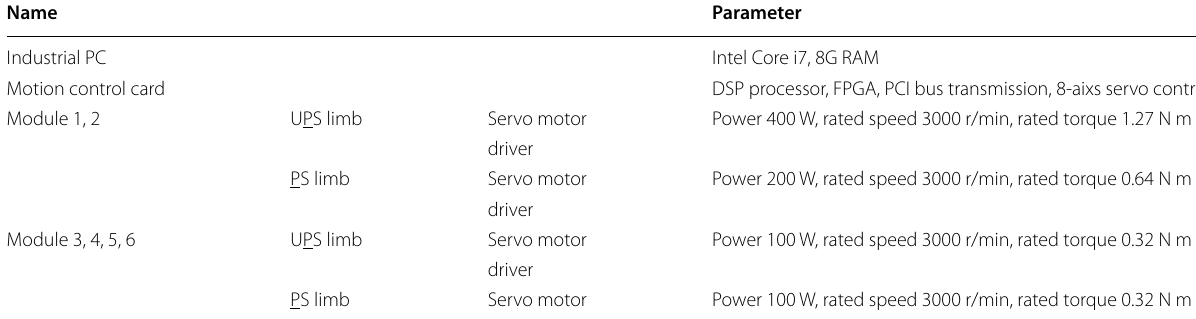
Table 3 Parameters of control system hardware